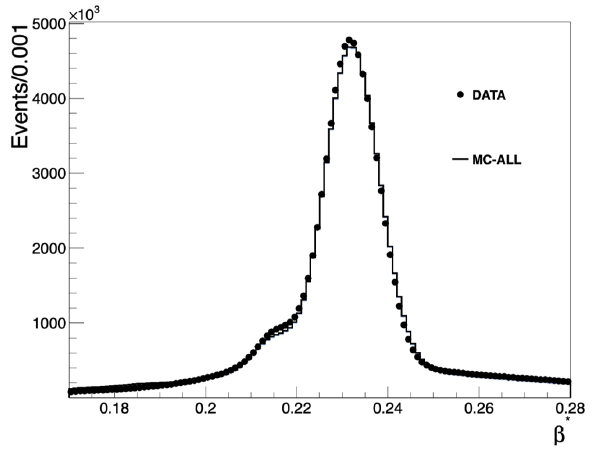
Figure 1 . Distribution of β ∗ after preselection for data and simulated